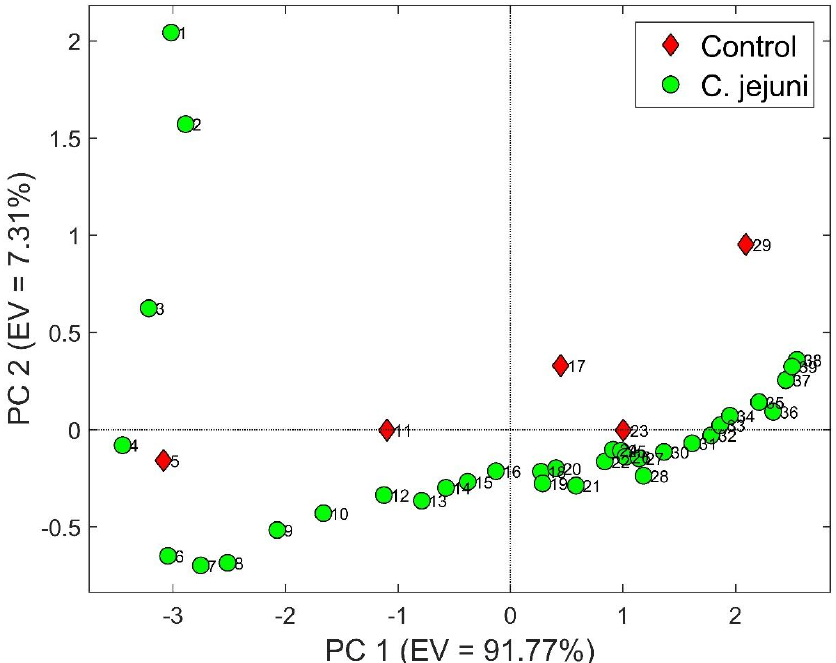
Figure 2. Principal Component Analysis (PCA) done with first two components (total variance equal to 99.08%). Green circles are C. jejuni samples, red diamond control ones.